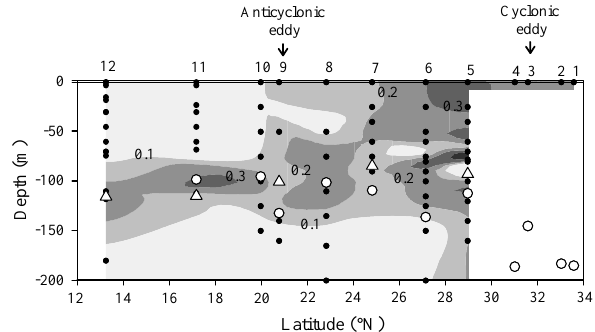
Fig. 10. Vertical profiles of chlorophyll a concentrations (µgdm − 3 ) measured during the cruise. The black dots are the sampled depths. The white circles are the mixed layer depths. The white triangles are the depths of 1% of photosynthetically active